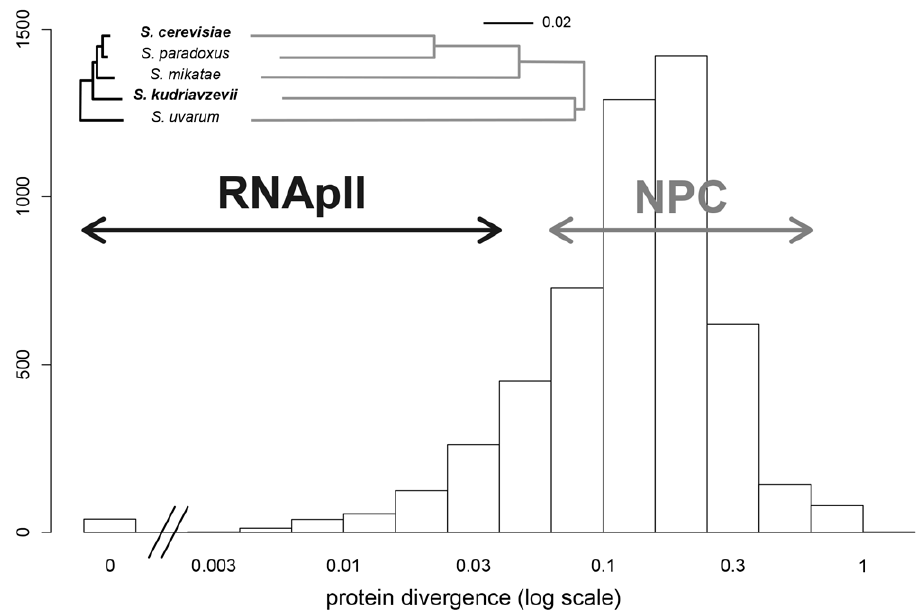
Figure 1. Protein divergence in the RNApII (black) and the NPC (grey) in the Saccharomycessensustricto group. Evolutionary trees were drawn for all proteins of a complex and are on the same scale (proportion of different amino acids). Distribution of protein divergence between Scer and Skud was calculated from multiple-sequence alignments available for 5261 orthologous proteins [23]. Arrows indicate protein divergence covered by the two complexes.